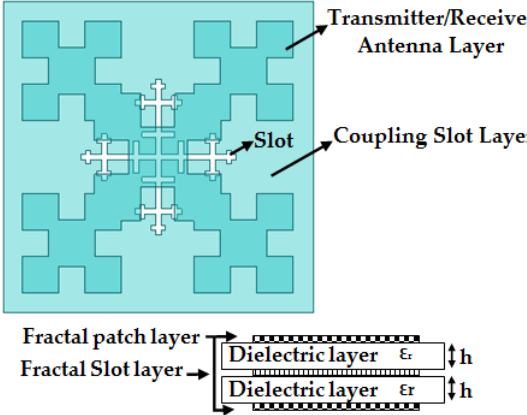
Figure 11. The Configuration of fractal Antenna-Filter-Antenna (AFA) based FSS with top and side view [74].